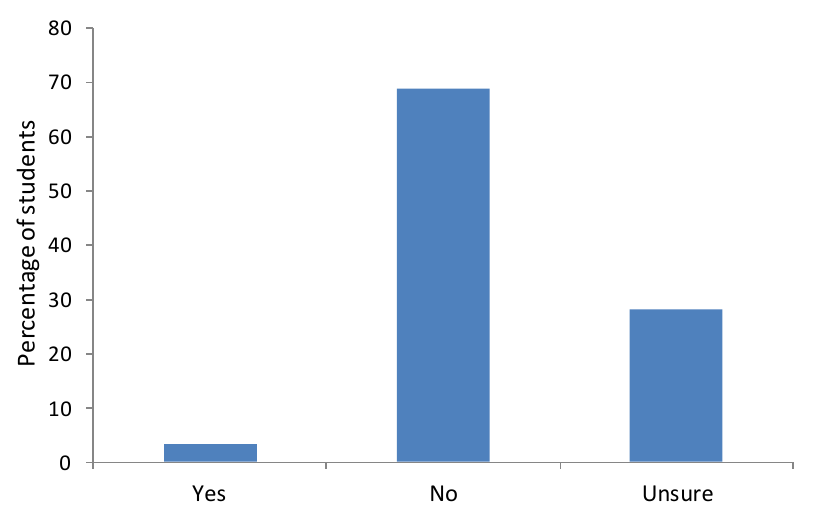
Figure 3. Importance of using the professor’s voice in the videos.